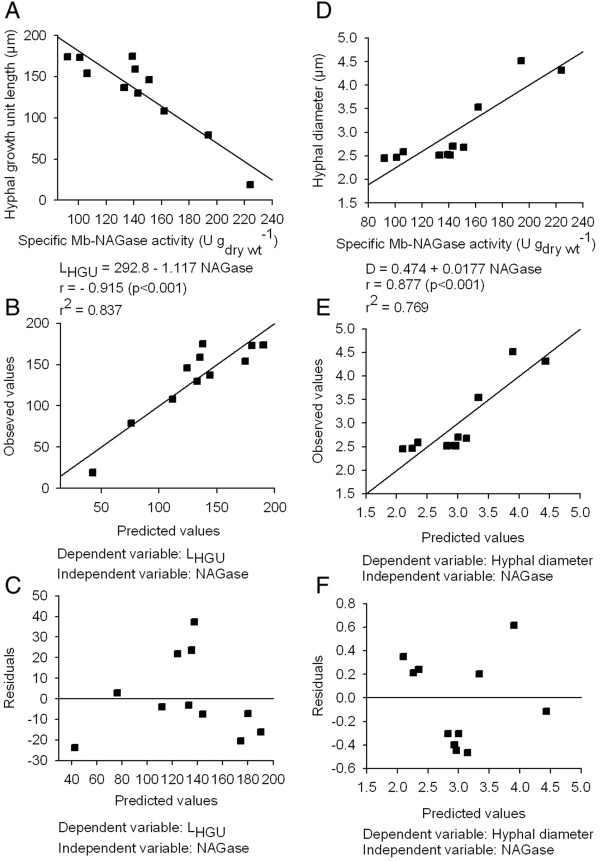
Relationships between the specific Mb-NAGase activity and the morphological indices in A. niger MYA 135. Correlation of specific Mb-NAGase activity with |HGU (A) and with the hyphal diameter (D). Observed versus predicted values of correlation between |HGU (B) or hyphal diameter (E), and specific Mb-NAGase. Residuals versus predicted values of correlation between |HGU (C) or hyphal diameter (F), and specific Mb-NAGase. Mb-NAGase (Mycelium-bound β-N-Acetyl-D-glucosaminidase), |HGU (hyphal growth unit length), D (Hyphal diameter).